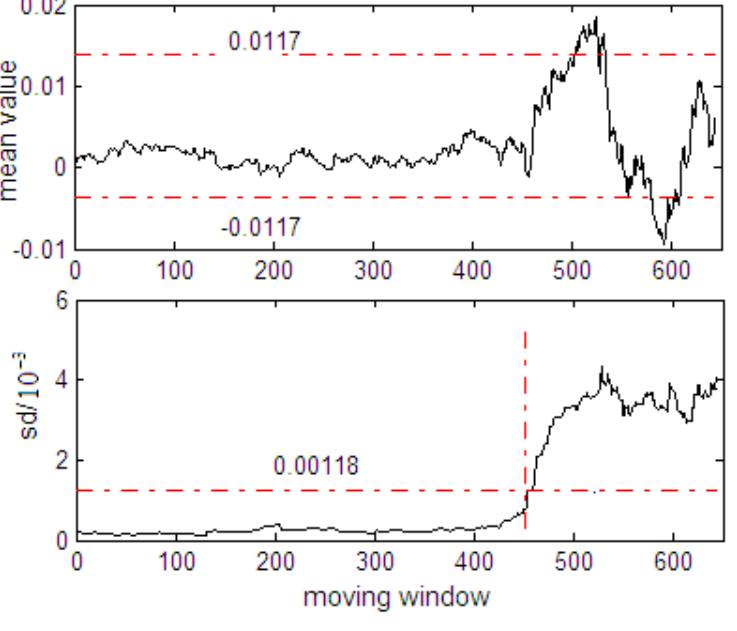
Figure 13. Statistical characteristics for Case